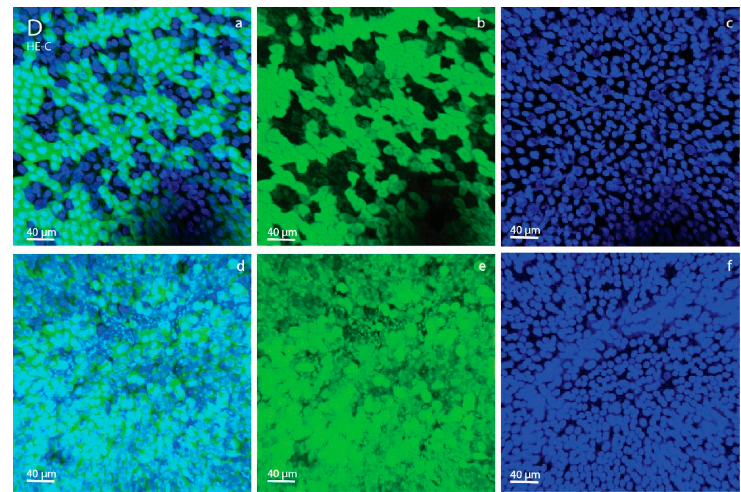
Figure 2. Confocal micrographs of stained allantochorionic (AC; a–c) and yolk-sac (YS; d–f) mem- branes, obtained using a Leica SPE II DMI-4000 confocal microscope (Leica Microsystems, Wetzlar, Germany), of day-28 embryos that were transferred on day 7 of gestation from a control to a control Shetland pony mare ( A ), high-energy (HE) to HE mare ( B ), control to HE mare ( C ) or HE to control mare ( D ). Cell nuclei are labeled with Hoechst (blue fluorescence). The green fluorescent-stained glucose analog 2-NBDG illustrates glucose uptake by the conceptus membranes. ( a , d ): merged micrograph; ( b , e ): blue channel (414–466 nm); ( c , f ): green channel (511–577 nm).